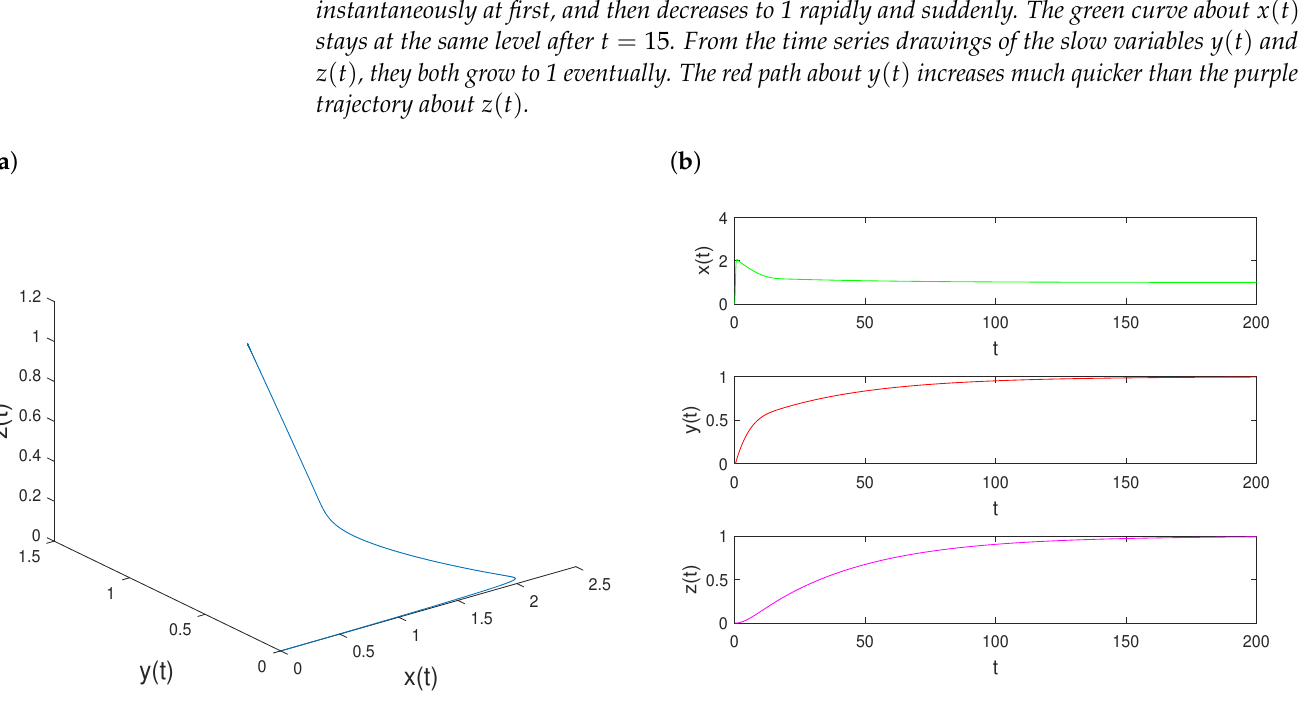
Figure 1. When x ( 0 ) = y ( 0 ) = z ( 0 ) = 0 and (cid:101) = 0.05: ( a ) dynamical behavior for the trajectory of system (8); ( b ) the three variables x ( t ) , y ( t ) , and z ( t ) in system (8) eventually settle down to constant